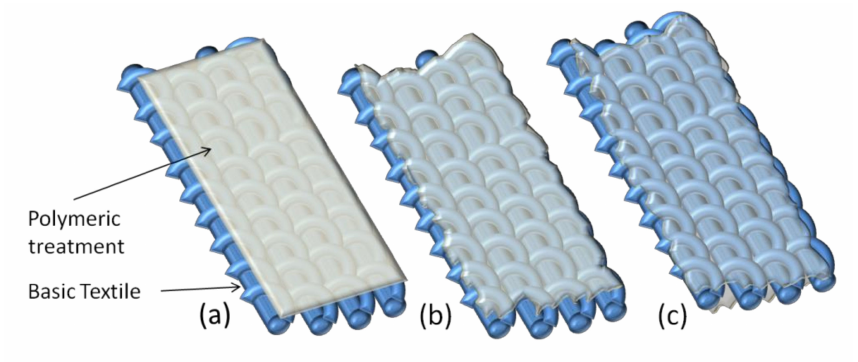
Figure 2. Different appearance of common treated textiles by lamination ( a ), coating ( b ), or impreg- nation ( c